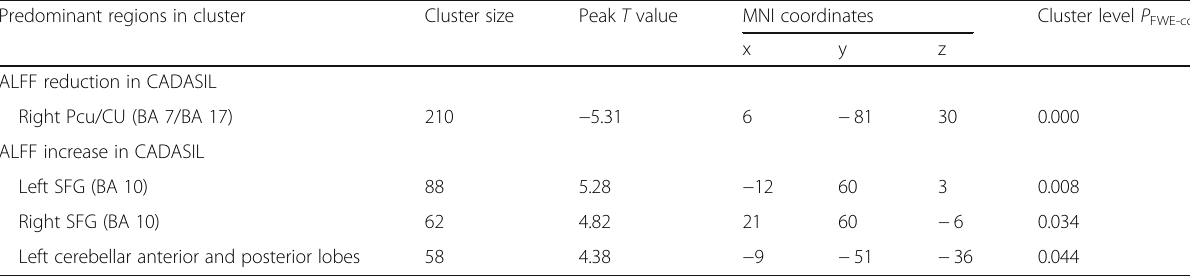
Table 2 Significant inter-group differences in ALFF among CADASIL and controls Predominant regions in cluster Cluster size Peak T value